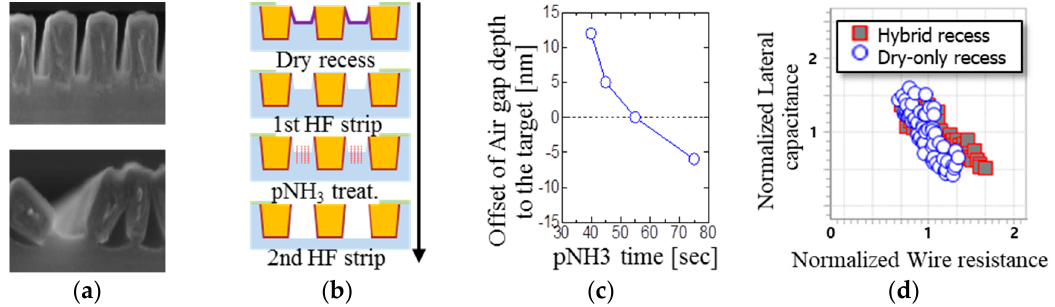
Figure 6. ( a ) Cross-sections of shallow and excessively deep AGs. ( b ) Process flow. ( c ) AG depth with respect to the pNH (cid:2871) time in the hybrid recess scheme. ( d ) Lateral capacitance vs. wire resistance of the AG wire with intermetal dielectric (IMD) recess schemes.